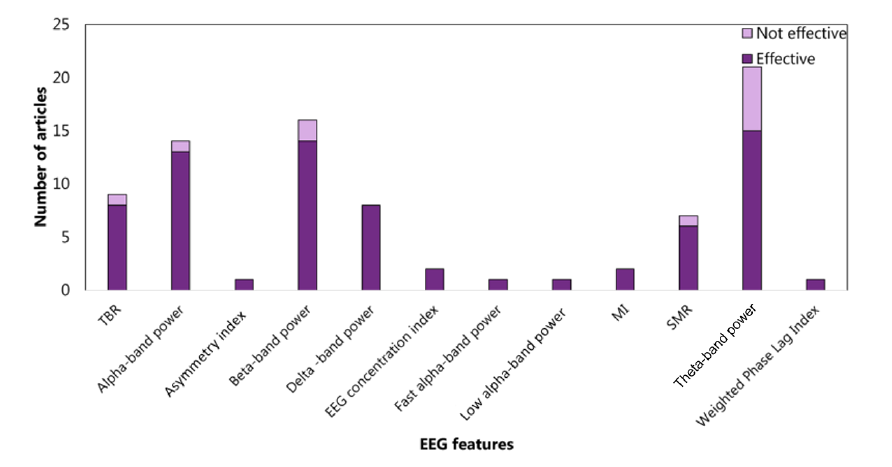
Figure 6. Articles focusing on the relationship between EFs from cluster inhibition and EEG features from frequency domain. Theta-band power is the feature most studied: 15 articles verified (effective) the relationship, and 6 articles did not (not effective). MI: modulation index. SMR: senso-motor